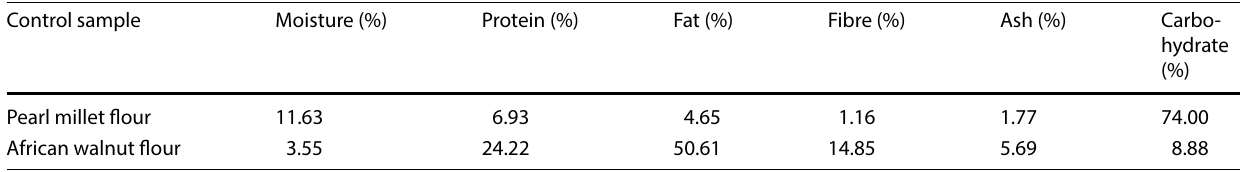
Table 2 Average values of proximate composition for pearl millet and African walnut flours (published data from other authors) Sources Adebiyi et al. [24], Obadina et al. [25], Fasogbon et al. [7], Tonfack Djikeng et al. [5] Control